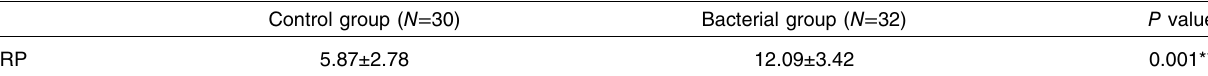
Table 17 Comparison between mean values of CRP in the control and bacterial groups Control group ( N = 30) Bacterial group ( N = 32) P value CRP 5.87±2.78 12.09±3.42 0.001** CRP, C-reactive protein. ** P < 0.01 relative to the control